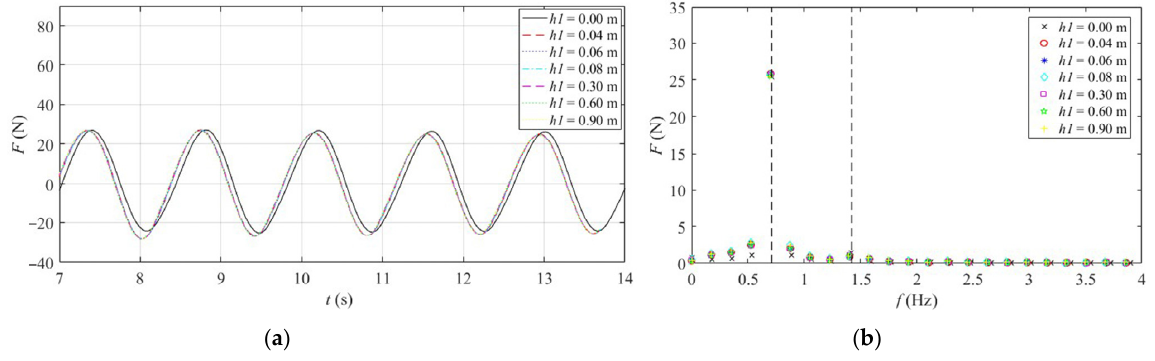
Figure 12. Load duration curve and spectrum of the combined structure under different cage submergence depths. ( a ) Time domain curve. ( b ) Frequency domain diagram.